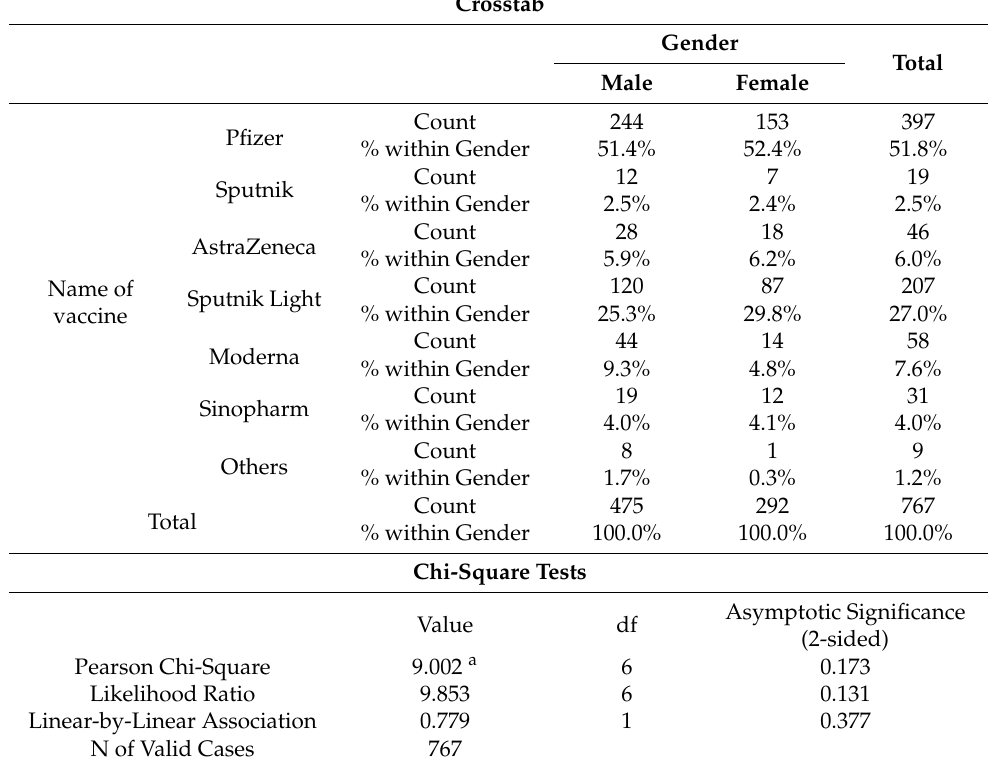
Table 8. Type of vaccine used by